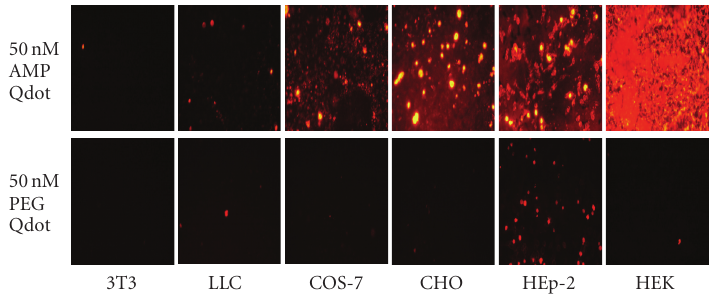
Figure 1: A comparison of nonspecific adsorption of AMP-coated qdots to the surfaces of 6 di ff erent cell types. These experiments employed AMP-coated qdots that were either unconjugated (upper row) or conjugated to PEG2000 (lower